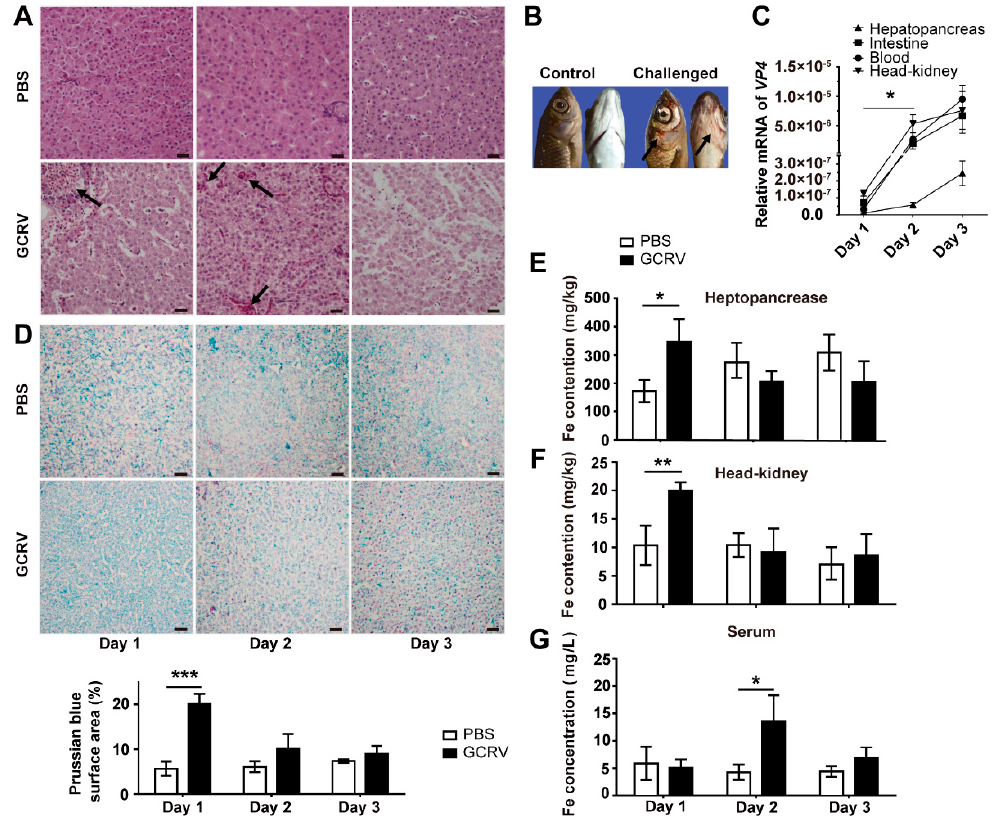
Figure 1. The iron contents in hepatopancreas, head / kidney, and serum in grass carp after grass carp reovirus (GCRV) infection. ( A ) Hepatopancreas damage in infected fish was detected using hematoxylin–eosin (HE) staining. Samples were collected and fixed at the indicated time points postchallenge. Arrows show the hepatic sinus hyperemia and the hydropic degeneration of hepatocytes. Bar = 20 µ m. ( B ) The symptoms of the GCRV-challenge test in grass carp. Arrows show hemorrhage sites at branchiostegite of infected fish. ( C ) mRNA expression levels of the VP4 gene of GCRV in hepatopancreas, intestine, blood, and head / kidney of infected fish were monitored. Data are presented in relative expression units where 18S rRNA was used to normalize all samples. ( D ) Iron in hepatopancreas was stained by Prussian blue, and nuclei were stained with fast red. Samples were collected and fixed at the indicated time points postchallenge. Bar = 20 µ m. Color density values were quantified by using ImageJ software. ( E , F ) The iron content in hepatopancreas ( E ) and head / kidney ( F ), detected by using ICP-OES. Samples were collected at the indicated time points postchallenge and then digested by using microwave for the iron content assay. ( G ) The iron content in serum, detected by using an automatic biochemistry analyzer. A total of 180 fish were used for each independent experiment. Data represent mean ± SD of three independent experiments. * p < 0.05, ** p < 0.01, *** p < 0.001.